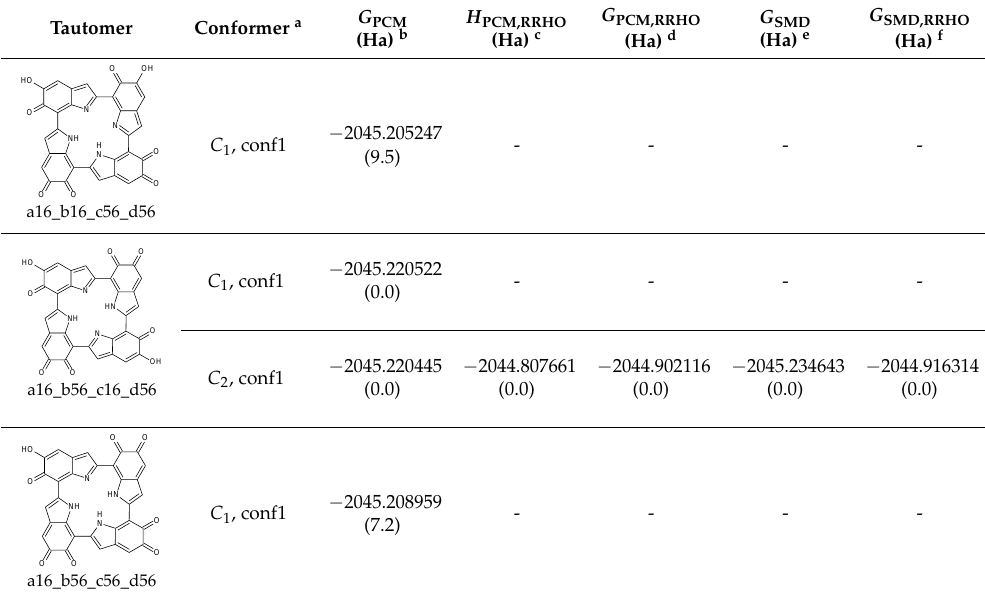
Table 16. KP-8e, neutral form in water.